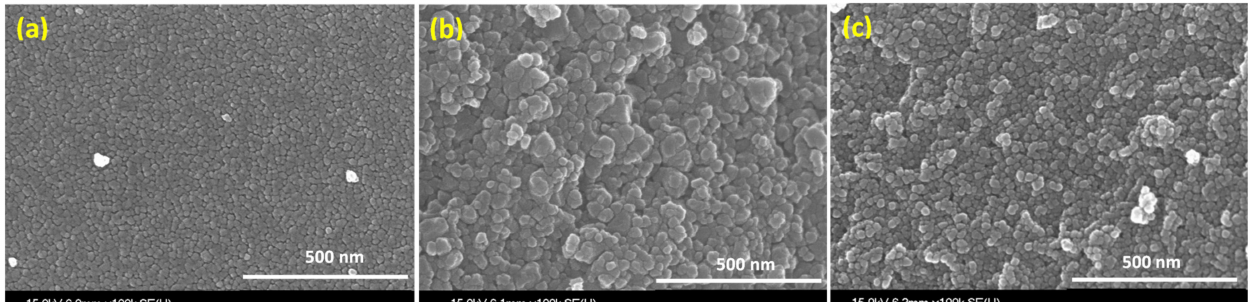
Figure 2. SEM images of ( a ) NFT, ( b ) NAT, and ( c ) NNT.